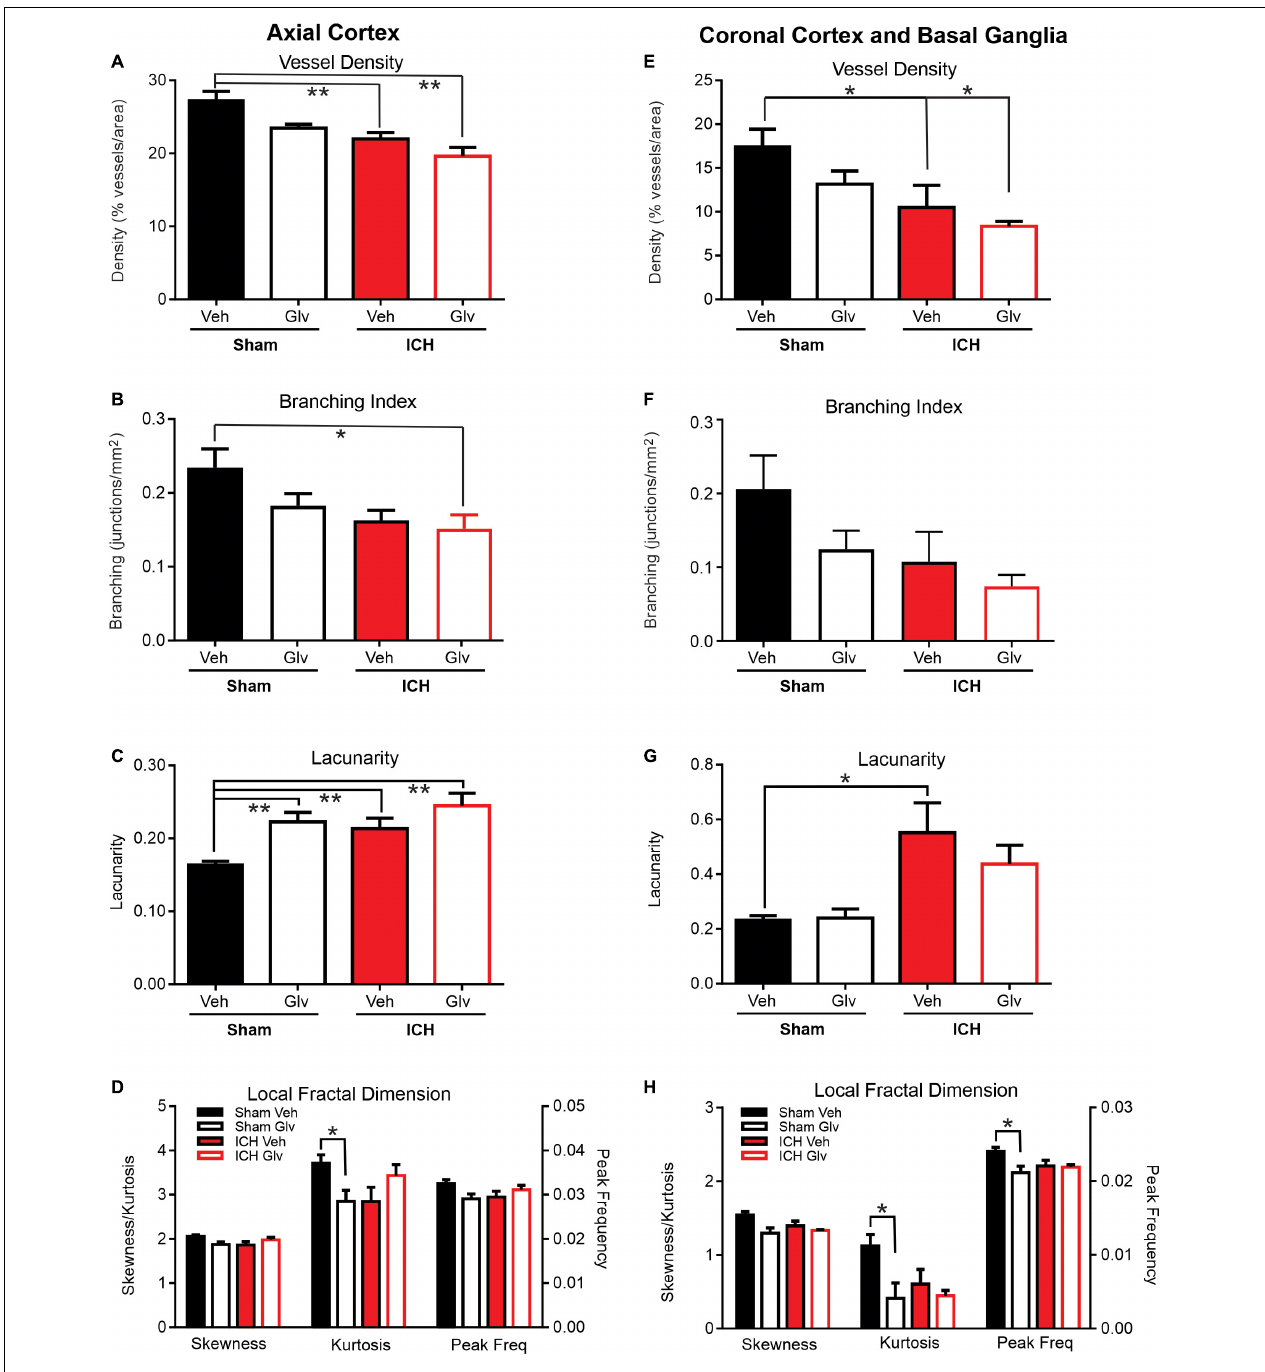
FIGURE 3 | Gleevec treatment does not improve ICH parenchymal vascular measures. Axial Cortex: Ipsilateral cortical vascular analysis revealed no significant changes in vessel density (A) or branching index (B) between Vehicle nor ICH Gleevec treated rats. However, significant reductions in vessel density were observed between sham vehicle and ICH + Vehicle and ICH + Gleevec rats. Vascular branching was significantly reduced between Sham + Vehicle and ICH + Gleevec rats. Lacunarity (C) was only increased in all groups relative to sham vehicle treated rats. Quantitative analysis of the distribution of LFD histograms (D) exhibited no significant reductions in skewness, and peak frequency in sham + Gleevec compared to sham + Vehicle animals. Kurtosis was significantly reduced between sham groups. Coronal Cortex and Basal Ganglia: Classical vascular analysis of ipsilateral cortex and basal ganglia revealed a progressively significant decrement in vessel density (E) across all groups. Post-hoc testing found significant differences between Sham + Vehicle and ICH groups (Vehicle, Gleevec). Branching index (F) and lacunarity (G) in sham nor ICH animals were not altered, except for a significant increase in lacunarity between sham + Vehicle and ICH + Vehicle rats. The distribution of LFD histograms (H) exhibited significant decreases in skewness, kurtosis and peak frequency across groups ( p < 0.05) but post-hoc testing observed significant decreases only in sham groups. (one way Anova with Tukey’s multiple comparisons, ** p < 0.03, * p < 0.05).